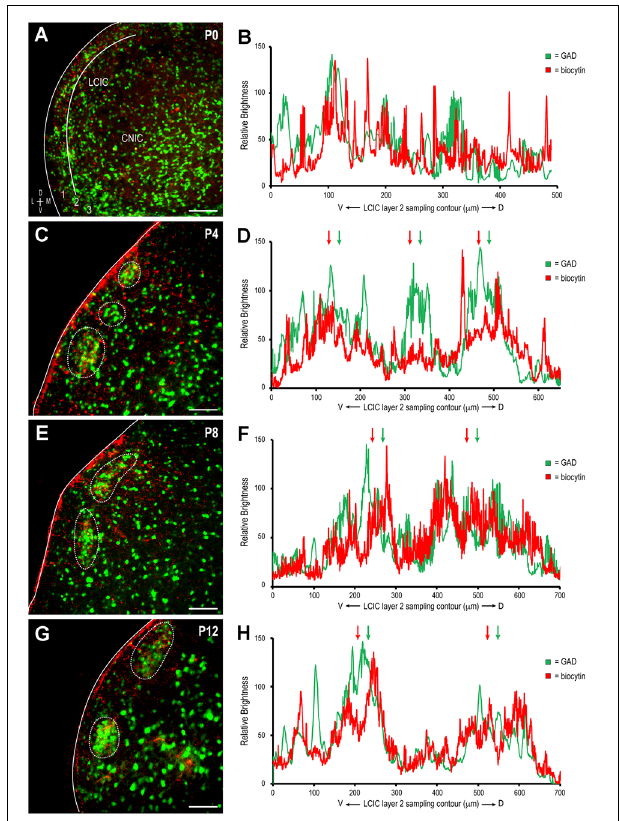
FIGURE 2 | Development of descending somatosensory modular projection patterns in the LCIC. Biocytin-labeled terminals (red) with emerging GAD modules (green) at P0 (A,B) , P4 (C,D) , P8 (E,F) , and P12 (G,H) . Note the increased specificity and alignment with age of patchy terminal fields within modular confines (dashed contours in C,E,G ) further evidenced by increased signal overlap in corresponding brightness profiles (arrows in D,F,H ). LCIC layers = 1, 2, and 3. Scale bars = 100 µ m.